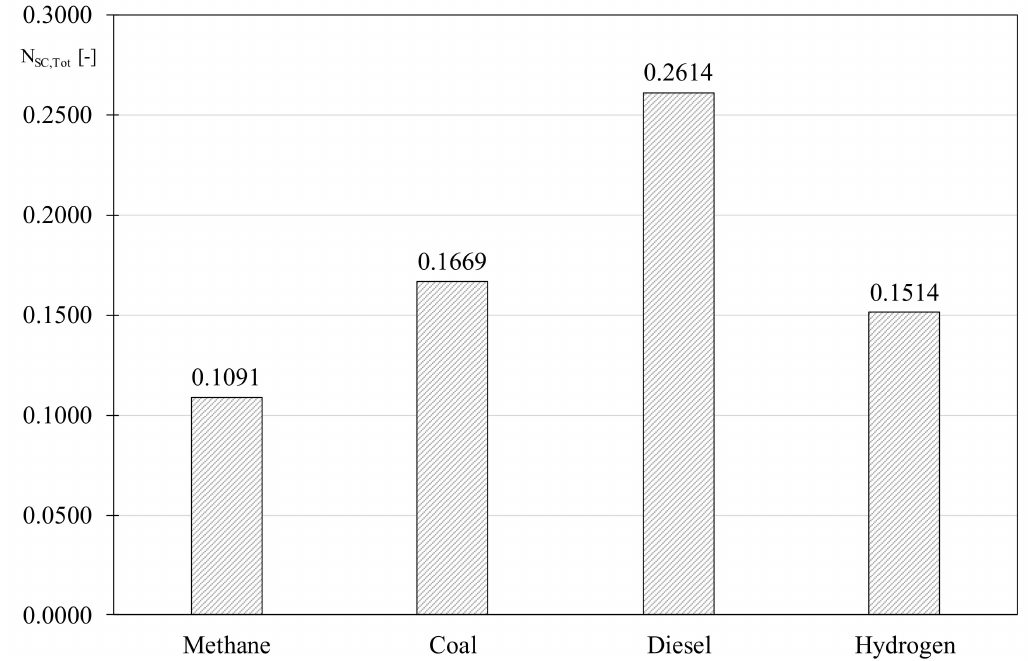
Figure 1. Entropic generation numbers (EGN) concerning the fuel thermodynamic properties in the combustion